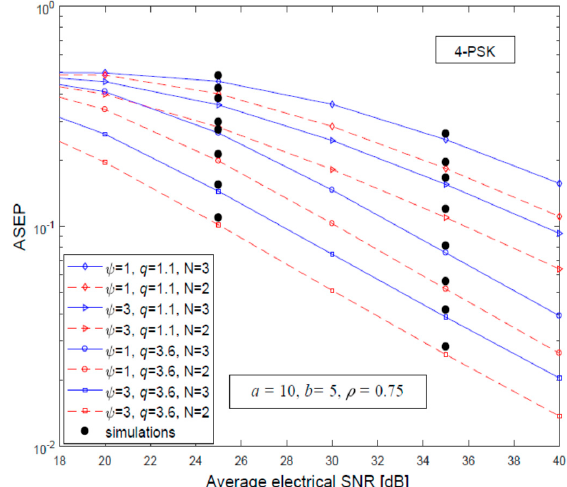
Figure 3. ASEP versus average electrical SNR of multi-hop FSO configurations for moderate turbulence strengths, weak and strong amounts of non-zero boresight pointing errors, and 4-PSK modulation formats with moderate and strong phase noise impairments.